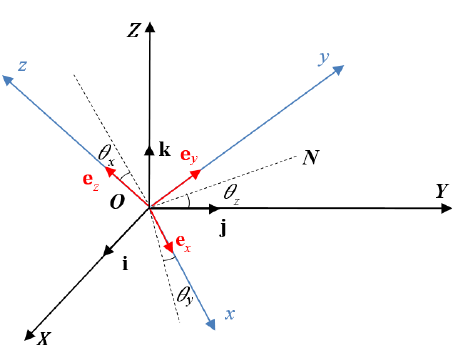
with the local oz and OY with the local oy .